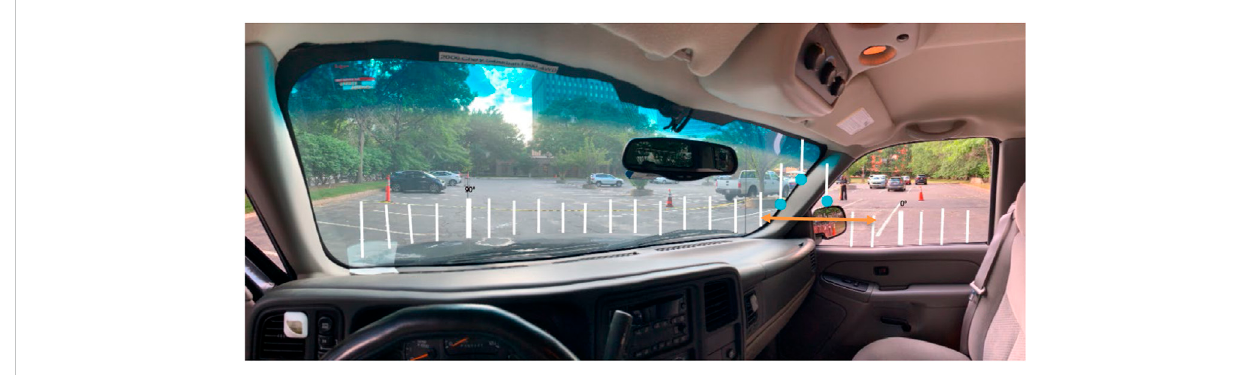
FIGURE 4 The non-visible points around the A-pillar in the forward seating position.